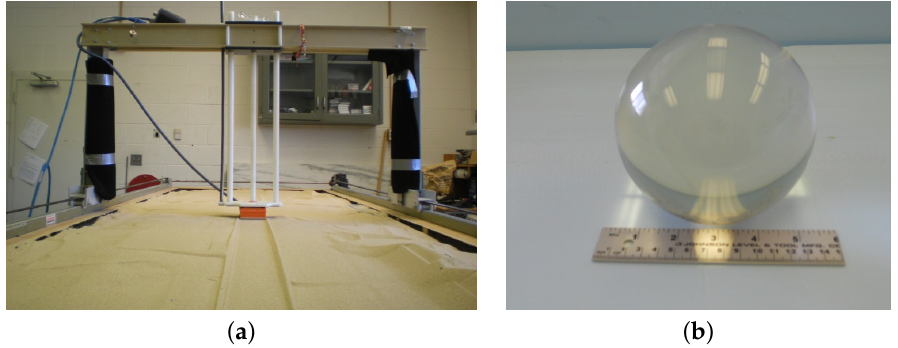
Figure 1. ( a ) Laboratory apparatus comprised a sand box and the high-frequency GPR (orange box) maintained on the sand surface by an automated transverse support. The size of the box in the picture is 1.2 m horizontally and 4 m in the vertical direction; ( b ) soda lime glass sphere of 0.12 m diameter buried in the sand box presented in full view of the experiment in ( a ).